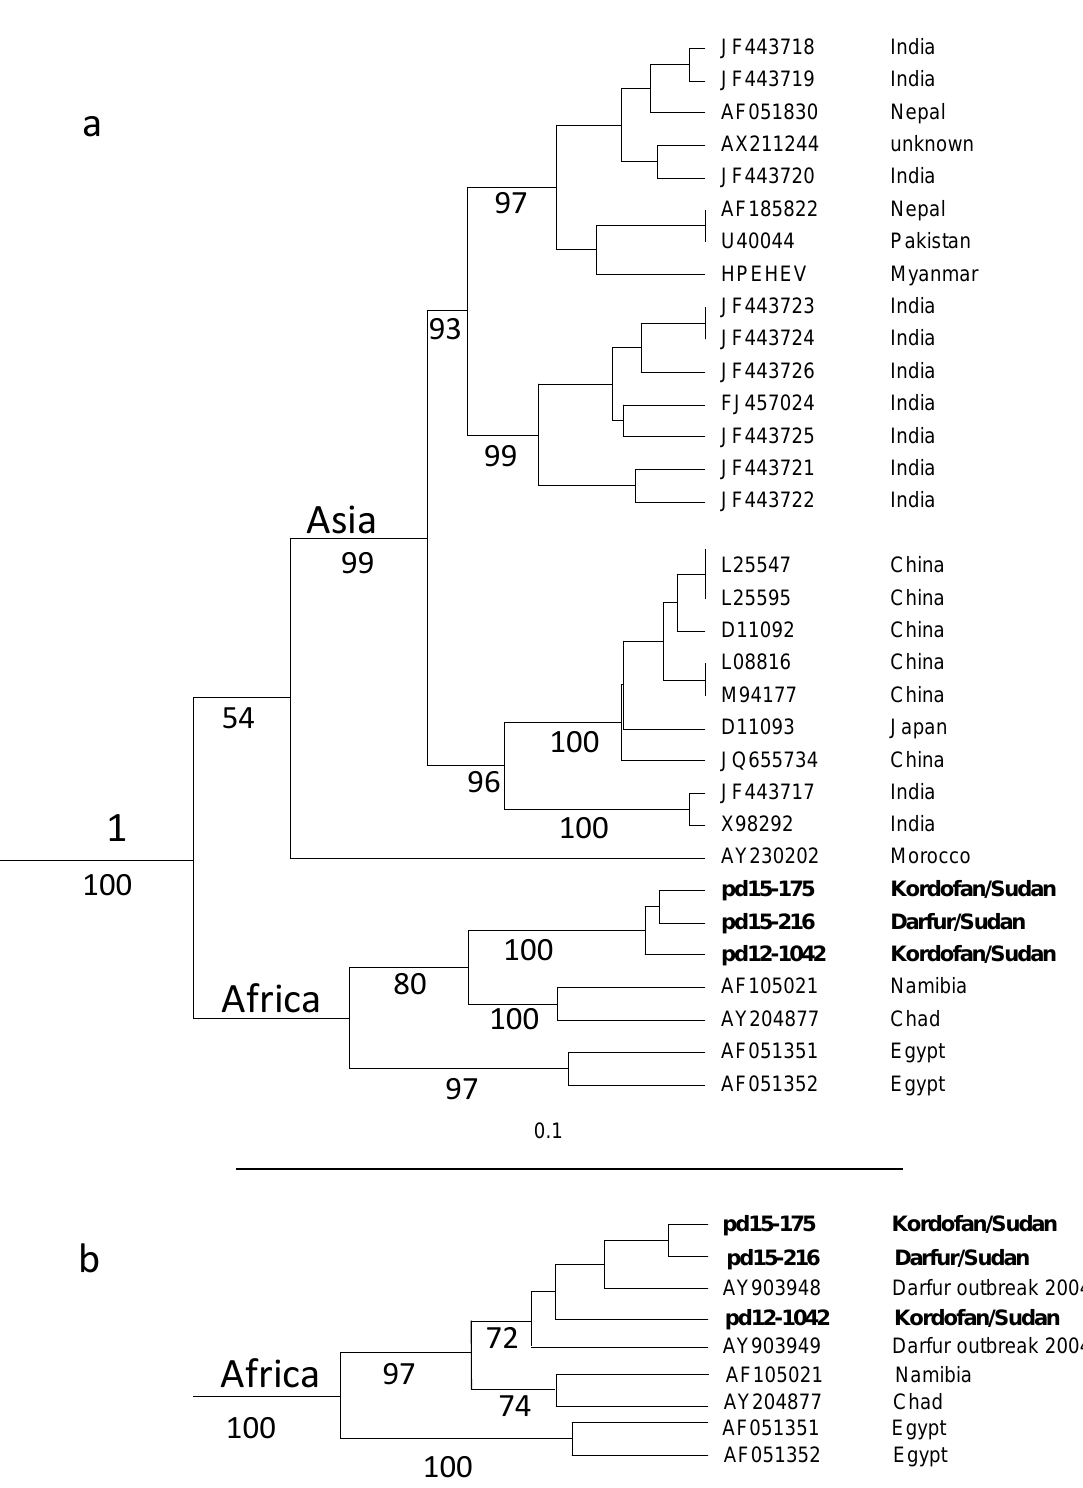
Figure 3. ( a ) Branch formed by 32 HEV genotype 1 (HEV1) strains in a phylogenetic tree based on 658 nucleotides of partial capsids in the ORF2 region; ( b ) Branch formed by the nine available HEV1 sequences from Africa in a phylogenetic tree based on 363 nucleotides of partial capsids in the ORF2 region. Boot strap values obtained from 1000 replicates are given at the branches. The accession numbers and origins of the strains are given at the